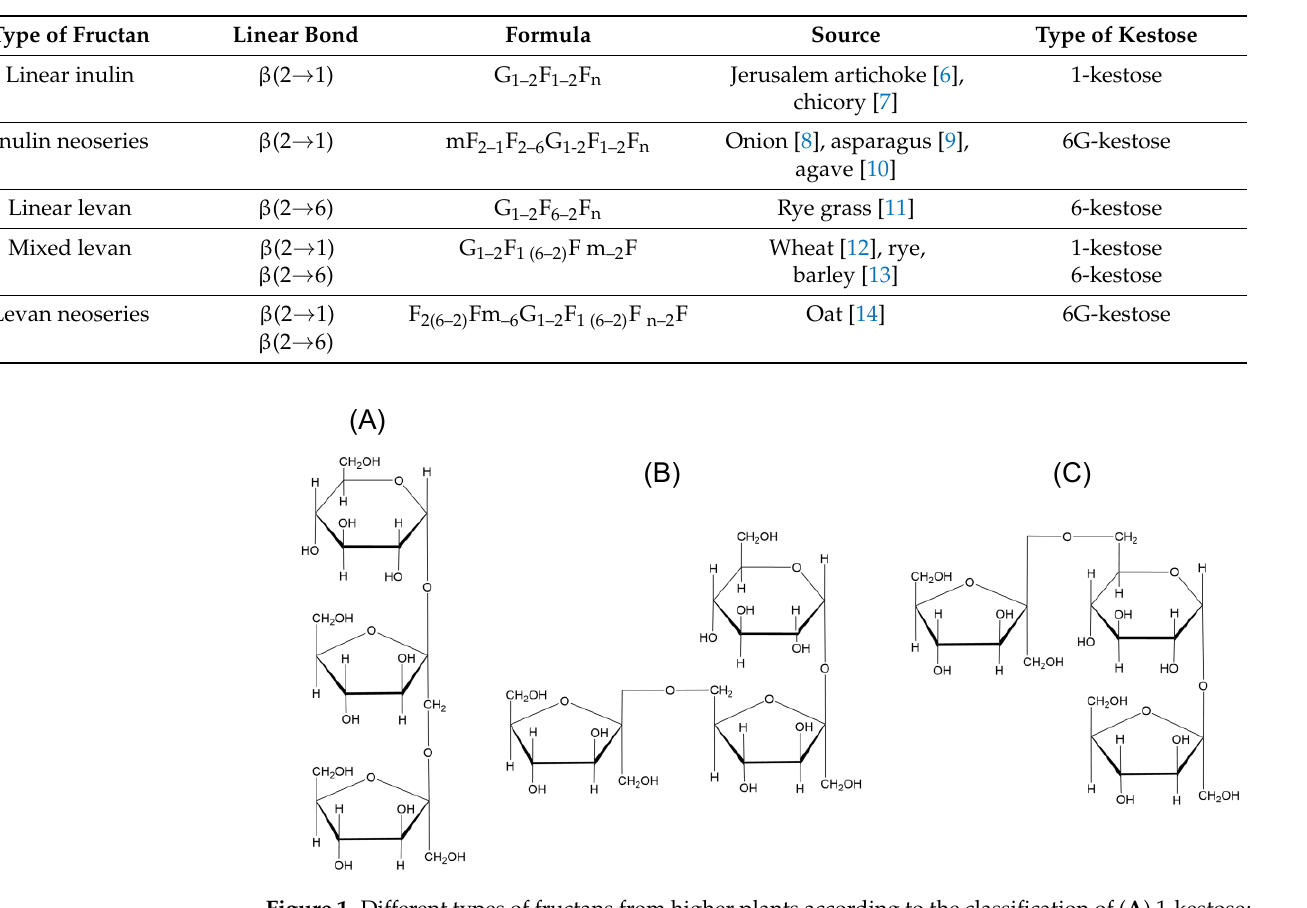
Figure 1. Different types of fructans from higher plants according to the classification of ( A ) 1-kestose; ( B ) 6-kestose; ( C ) neokestose. Structurally, fructans comprising linear glucosyl- α (1 → 2)-(fructosyl) n - β (2 → 1)